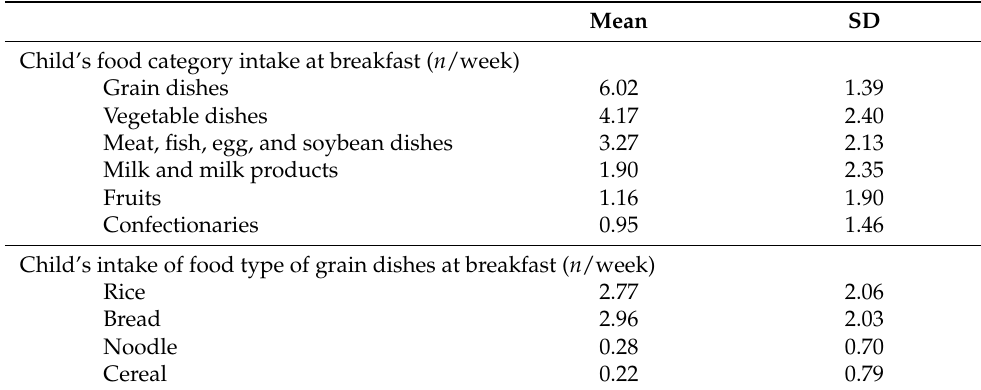
Table 2. Breakfast intakes by the Japanese school children ( n = 281).